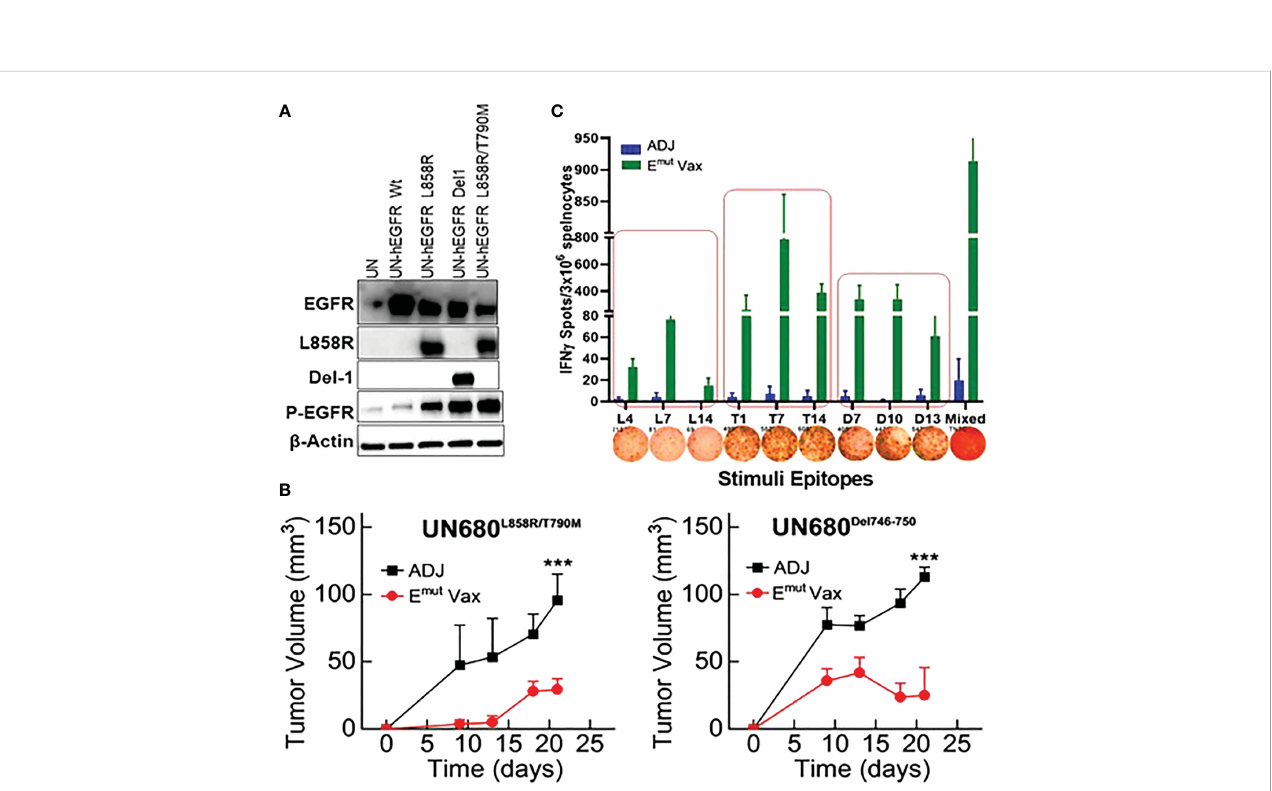
FIGURE 2 E mut Vax inhibits lung tumor progression in syngraft models. (A) Western blots to con fi rm expression of different mutant forms of EGFR in UN680 cells. (B) Tumor volume quantitation over time in the L858R/T790M resistant UN680 syngraft tumor model (left panel) or UN680 Del19 syngraft model (right panel). (C) Quanti fi ed and representative (insets) ELISPOT results from the spleens harvested at the endpoint of the ef fi cacy study from the UN680 syngraft models. Data were combined from both L858R/T790M resistant or Del19 syngraft models. Data are the mean ± SE, n=10, ***P ≤ 0.001 vs Adj